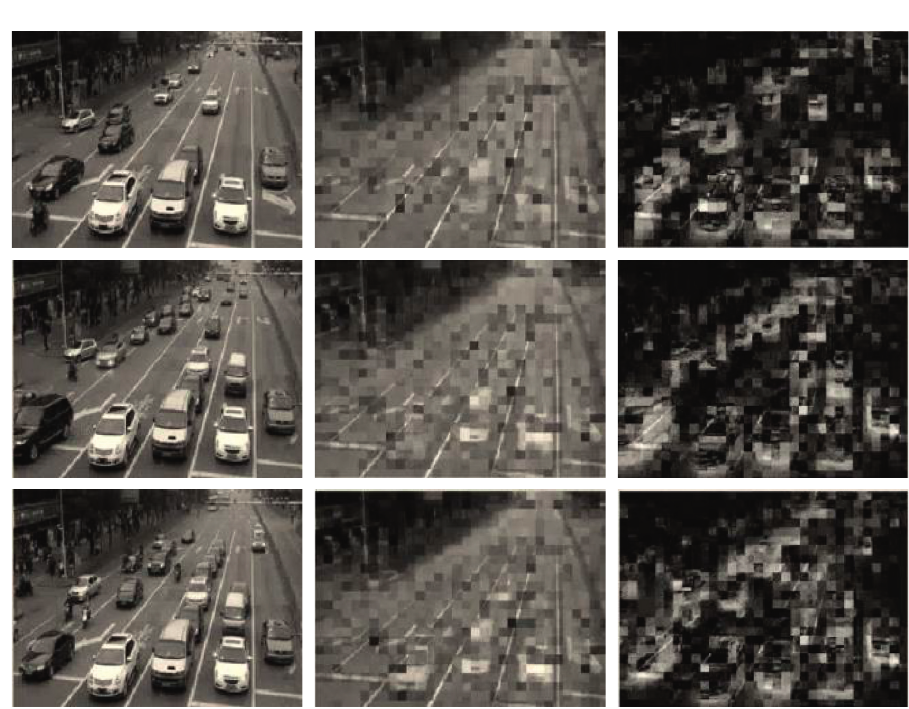
Figure 3: Detection results of the standard sparse representation method.